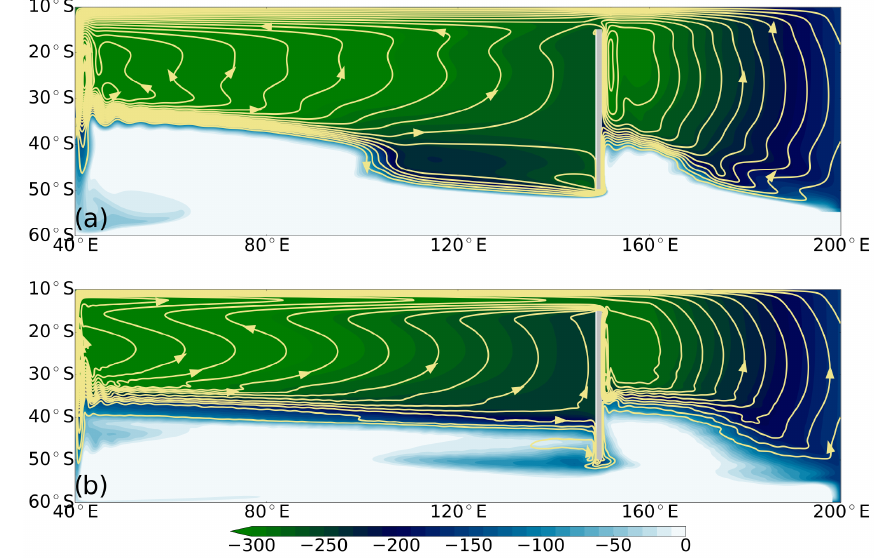
Figure 7. As Fig. 6 including wind forcing in the eastern basin for (a) viscous and (b) inertial circulation.